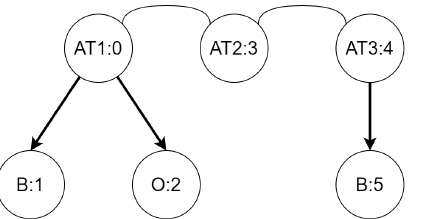
Figure 4. The initial state of a system in the example of verifying model correctness.